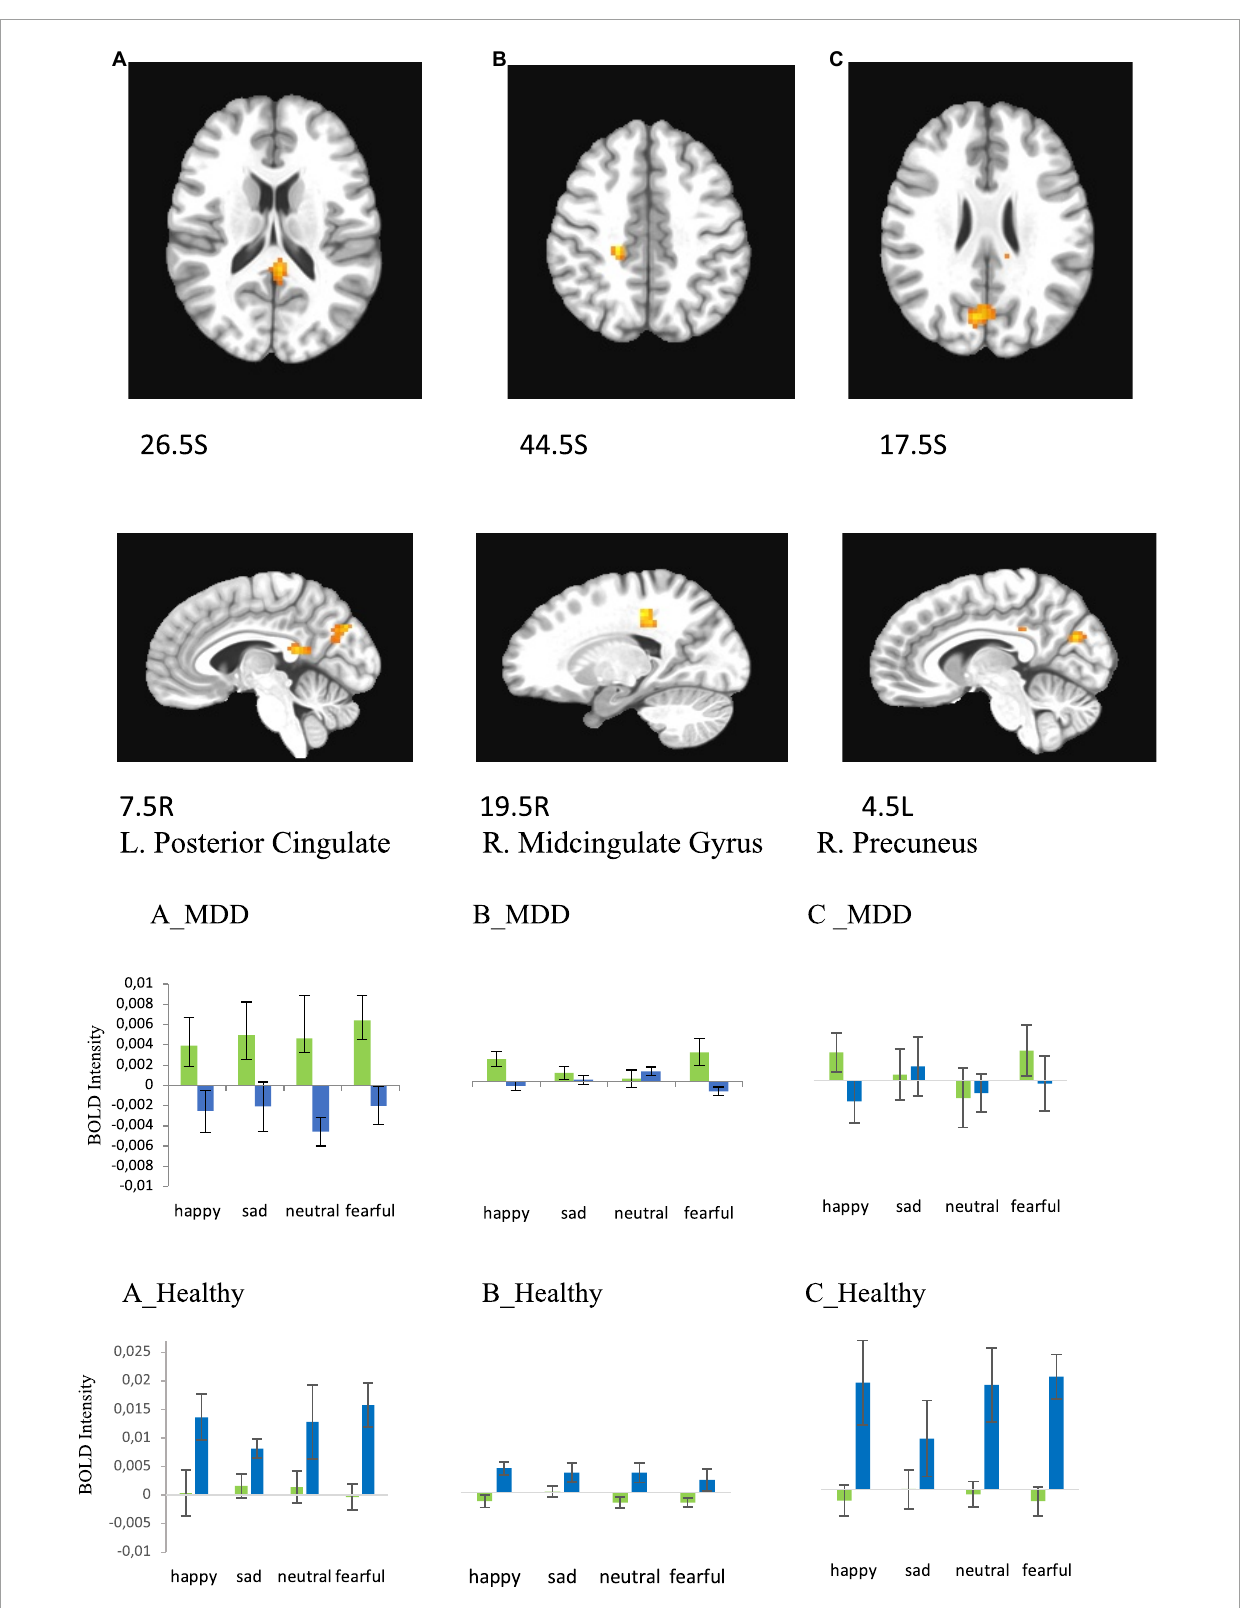
FIGURE7 Brain regions that showed significant sex × group effect in MDD and Healthy participants for presentations of happy, sad, fearful, and neutral faces [females – green color, males – blue color; (A) left posterior cingulate, (B) right cingulate gyrus, (C) right precuneus (BA31)]. Plots for ROI that displayed a significant difference in BOLD intensity between females and males in MDD group [ (A–C) , MDD group] and Healthy group [ (A–C) , Healthy group] ( p <